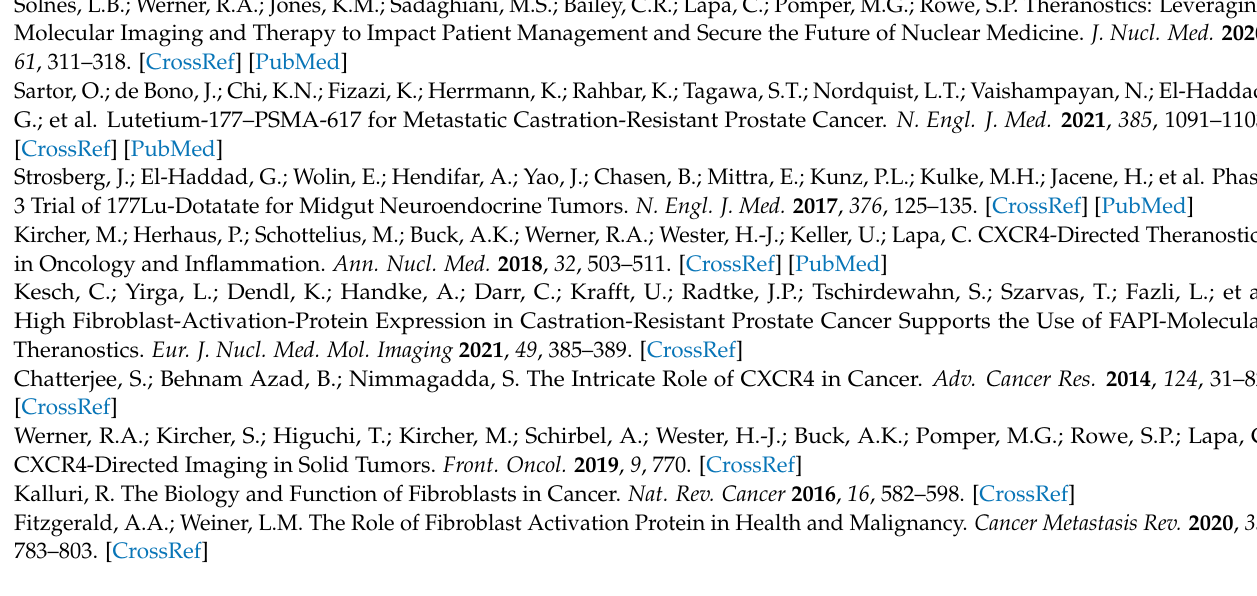
sequencing dataset representing head and neck cancer (GSE103322). Figure S5: Cell-type specific expression of FAP and a selection of angiogenesis-related genes within a single cell sequencing dataset representing head and neck cancer (GSE103322). Table S1: Proportion of tumor specimens overexpressing CXCR4 or FAP – according to underlying tumor entities from the TCGA (The Cancer Genome Atlas) database. Table S2: Independent validation cohorts with respective cancer entities, sample numbers, and data sources. Table S3: Top 200 genes identified by RF learning being most discriminative for CXCR4 high- vs. CXCR4 low-expressing cancer samples. Table S4: Top 200 genes identified by RF learning being most discriminative for FAP high- vs. FAP low-expressing cancer samples. Table S5: CXCR4- (A) and FAP-specific (B) gene signatures analyzed using the “investigate gene sets” module of the Gene Set Enrichment Analysis (GSEA) webpage. FDR: false discovery